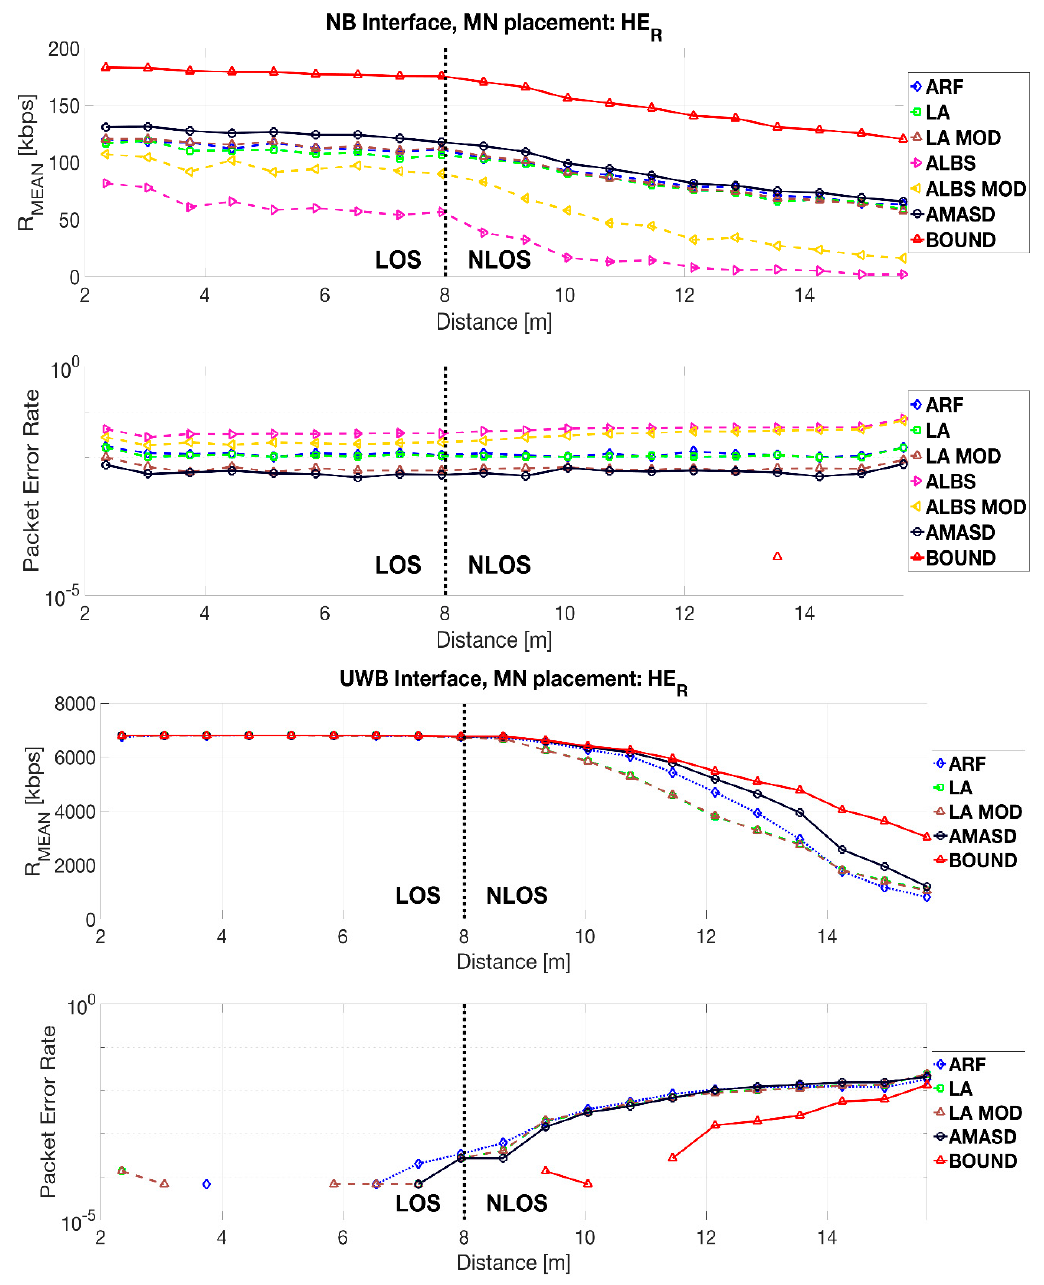
Figure 8. The mean bitrate (R MEAN ) and PER results as a function of the distance for the right side of the head (HE R ) mobile node (MN) placement for the NB and the UWB interfaces .